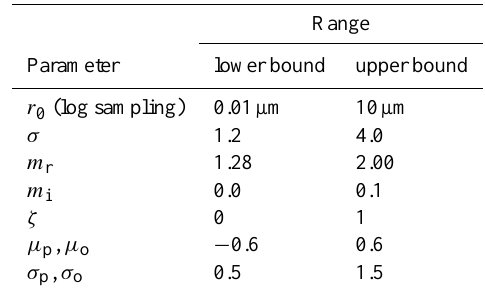
Table 1. Ranges of microphysical parameters used for Monte Carlo sampling of the ensembles. Parameters include the modal radius, r 0 , and the width of the log-normal size distribution, σ , the real, m r , and imaginary, m i , parts of the refractive index, the ratio of prolate spheroids to all spheroids, ζ , parameters of modified log-normal as- pect ratio distributions (Eq. 16 of Gasteiger et al., 2011a) for prolate spheroids ( µ p , σ p ) and independent aspect ratio distribution param- eters for oblate spheroids ( µ o , σ o